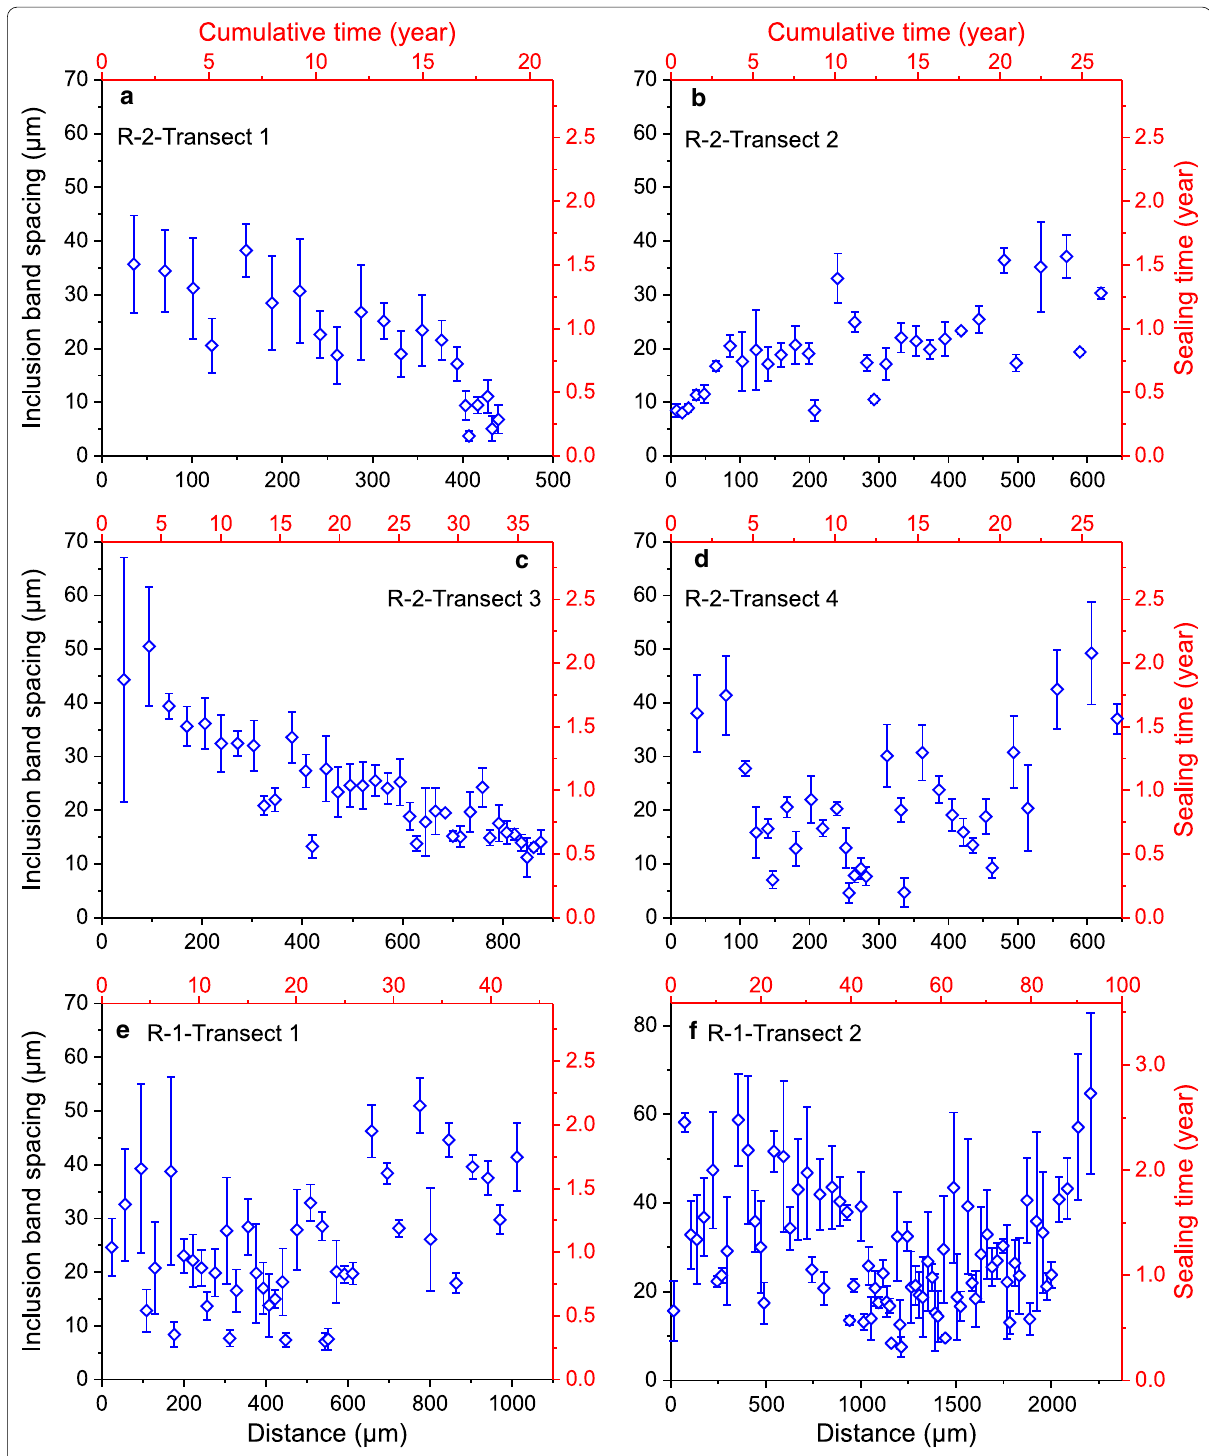
Fig. 3 Spatial changes in the inclusion band spacing for transects 1–4 in sample R2 ( a – d ) and for transects 1–2 in sample R1 ( e , f ). Right and upper axes (red) represent the sealing time between crack-seal events as a function of cumulative